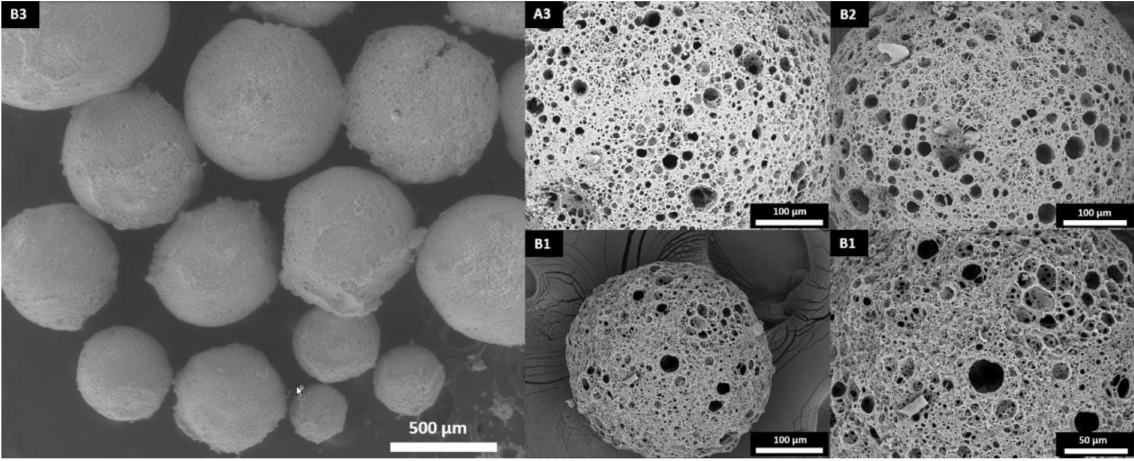
Figure 3. Surface morphology of the polyHIPE